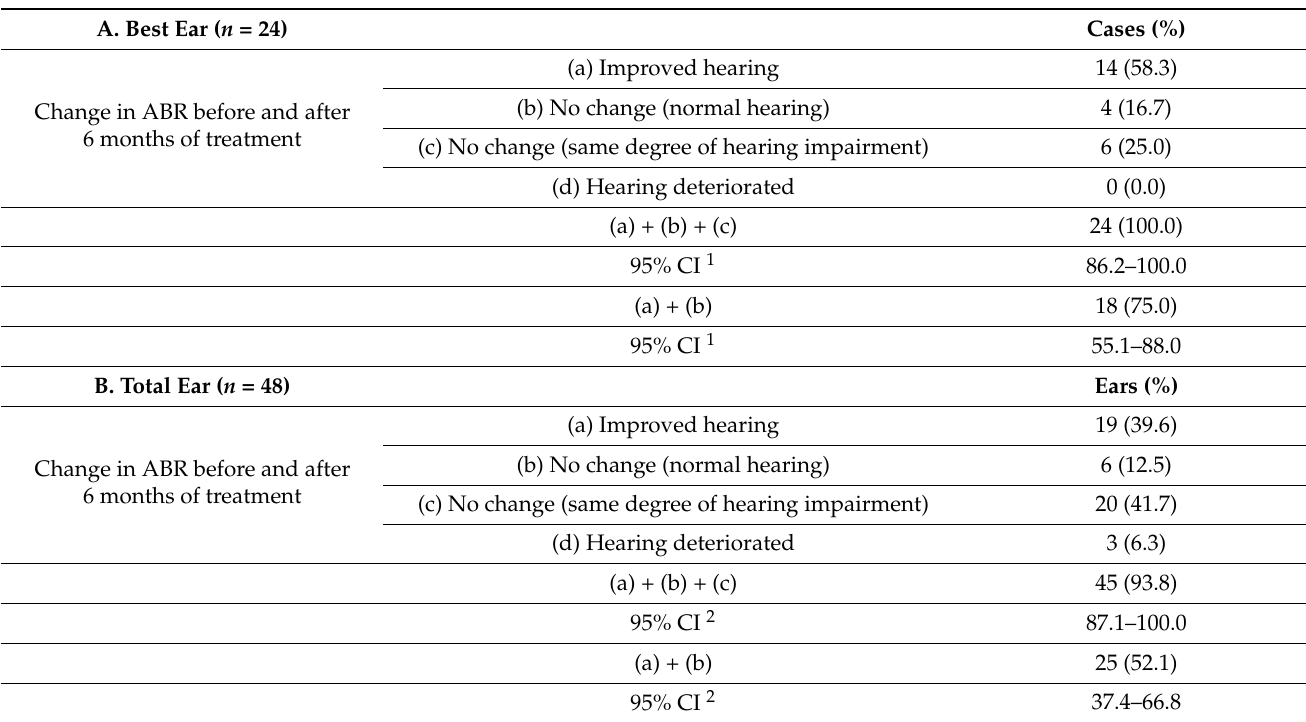
Table 2. Assessments of best ear and total ear hearing using auditory brainstem responses before and after 6 months of treatment.